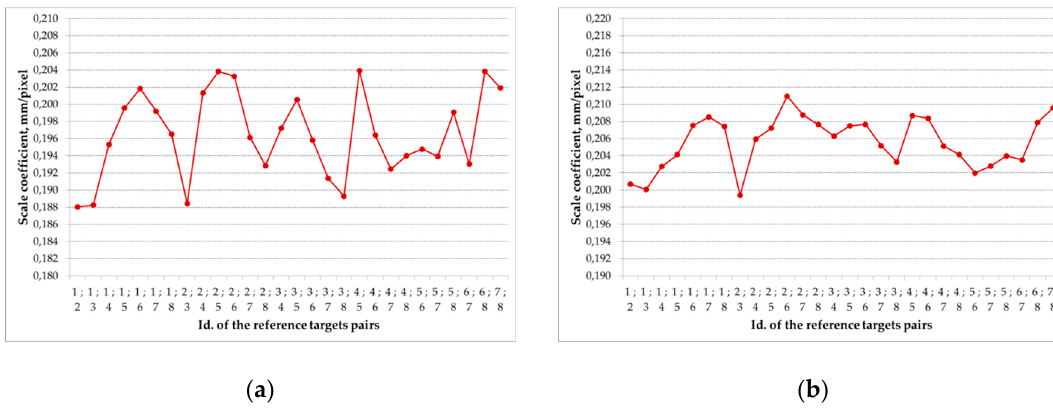
Figure 11. Dispersion of the scale coefficient values for: ( a ) referential A; ( b ) referential B.